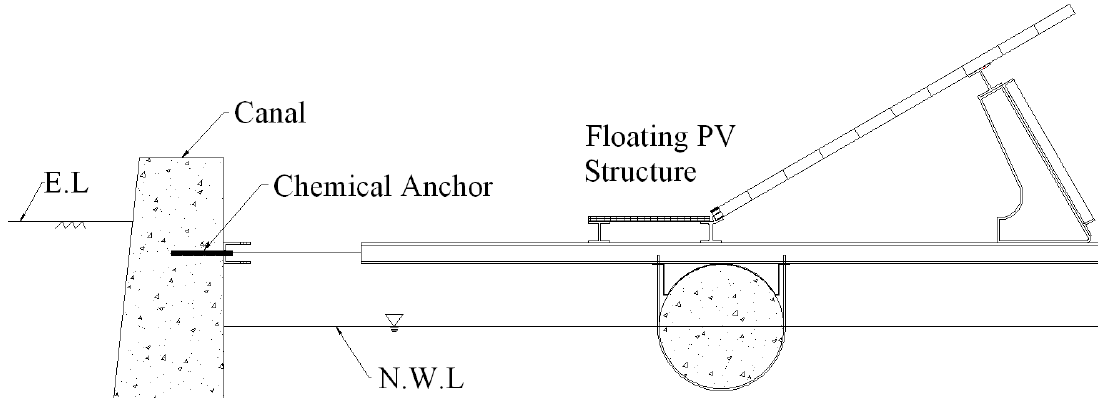
Figure 8. Anchor mooring system.